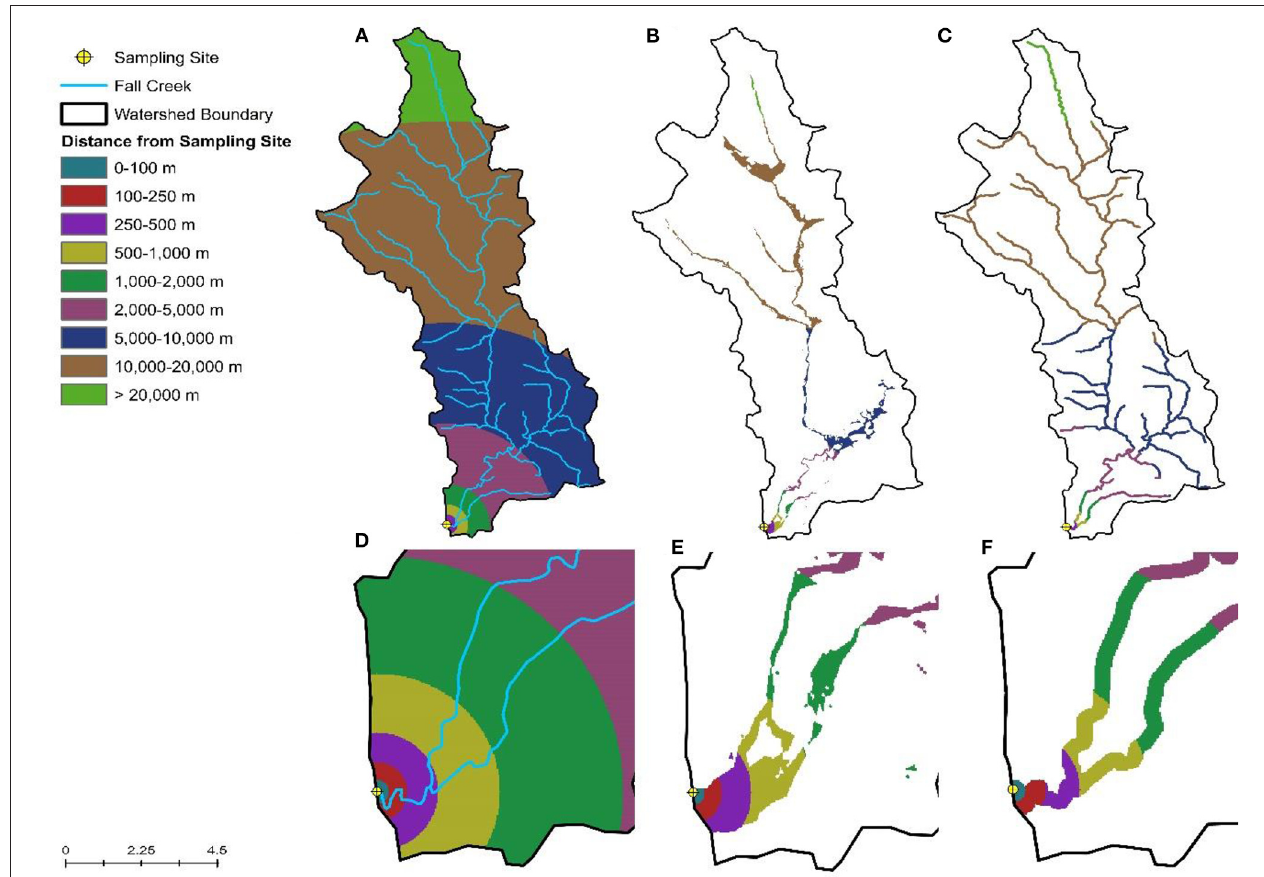
FIGURE 2 | Visualization of the inverse distance weighting approach used to calculate the percent of the watershed (A) , floodplain (B) , and riparian buffer (C) under different land uses. (D–F) Provide a close-up view of (A–C) , respectively, for areas near the sampling